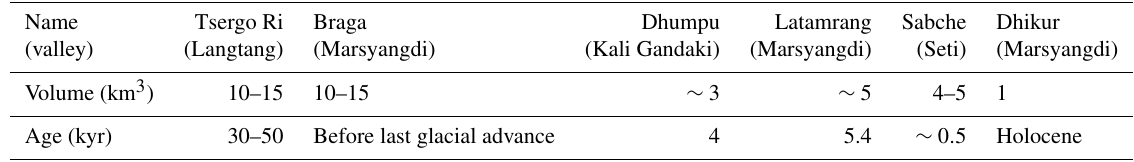
Table 1. Summary of the age volume and location of the giant deposits considered in our study area. All of them are considered single failures, except for the Sabche deposits that may have been deposited through three main events. See text for more